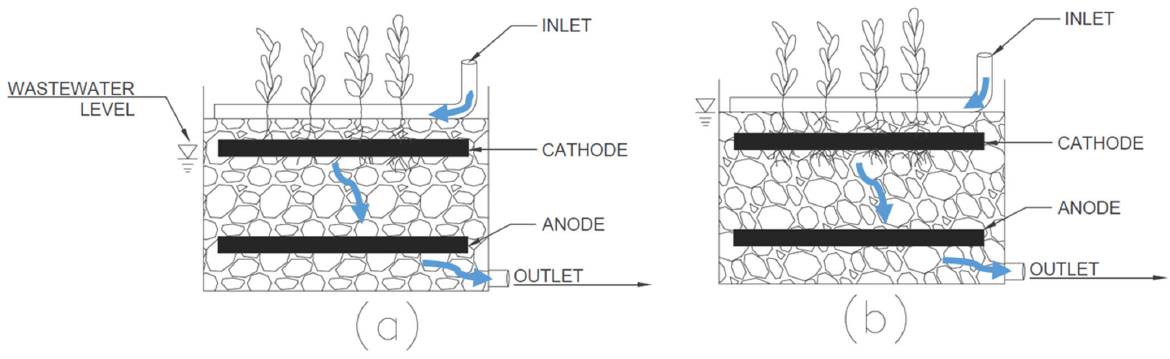
Figure 6. Representation of the ( a ) CW ‐ ACMFC and ( b ) CW ‐ MFC) ( adapted from Yan et al., 2018 [62]). Three different indigenous wetland plants ( Cyperus prolifer , Wachendorfia thyrsiflora , and Phragmites australis ) were investigated by Oodally et al. (2019) [48]. In their study, the CW ‐ MFC with C. prolifer produced the highest power density (229 ± 52 mW/m 3 ) and volt ‐ age (510 mV). The maximum power density was 24% higher with C. prolifer than that of the control (unplanted), whereas the maximum power densities with W. thyrsflora and P. australis were 42% and 41% less than the control, respectively. Oodally et al. (2019) [48] suspected that W. thyrsflora and P. australis were not acclimated to the initial environment that had a high concentration of ammonia in the wastewater. Noticing that C. prolifer de ‐ veloped its roots more extensively than the other two species, it can be presumed that the